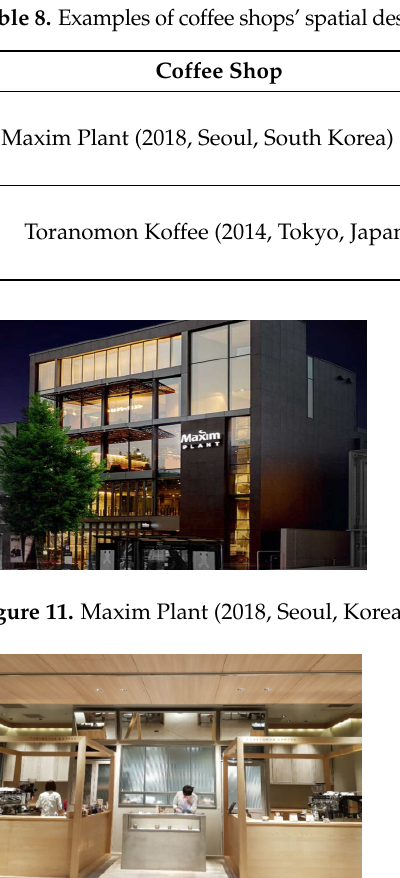
Figure 12. ToranomonKoffee (2014, Tokyo, Japan).